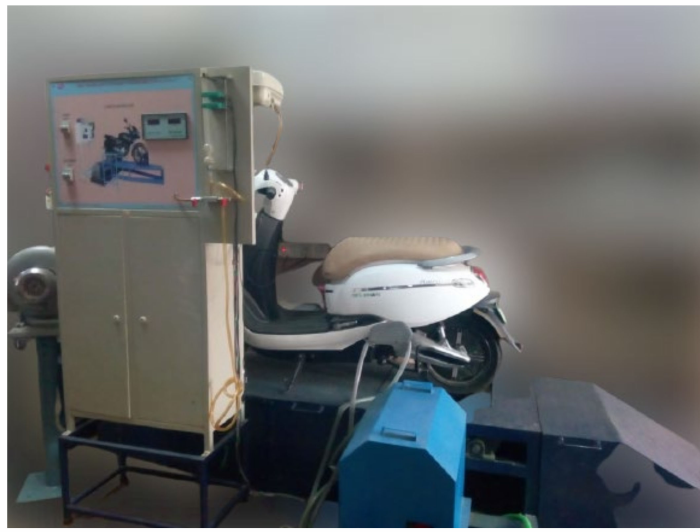
Figure 10. Two-Wheeler Chassis